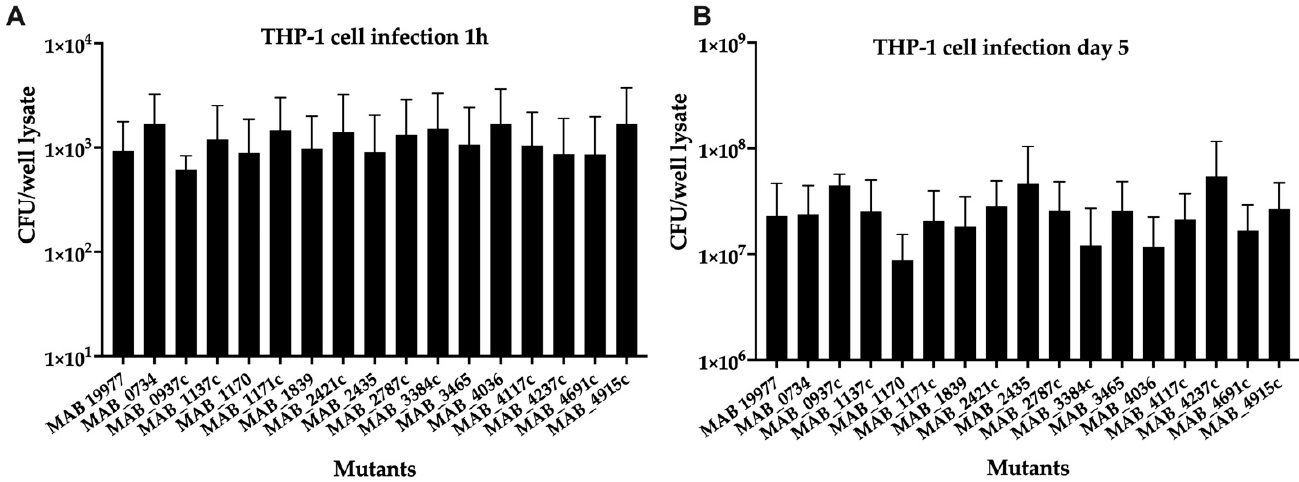
Figure 3. The intracellular survival of MAB mutants associated with surface transport systems. The THP-1 monocytes were differentiated with 20-ng/mL PMA in 96-well plates and rested for 3 days to form confluent monolayers. The macrophages were then infected with one of 15 mutants or the wild-type MAB 19977 (control) at a MOI of 1:1. While an infection rate was measured at 1 h ( A ), the survival rates were determined at 5 days post-infection ( B ) by lysing cells with 0.1% Triton X100 and plating lysates on 7H10 agar plates for viable bacterial CFU/well counts.